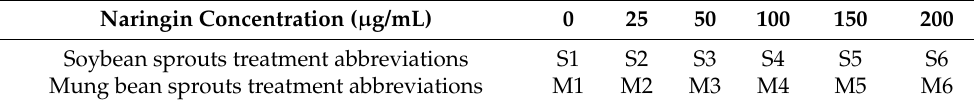
Table 1. The corresponding abbreviations for the soybean sprouts and mung bean sprouts. Naringin Concentration ( µ